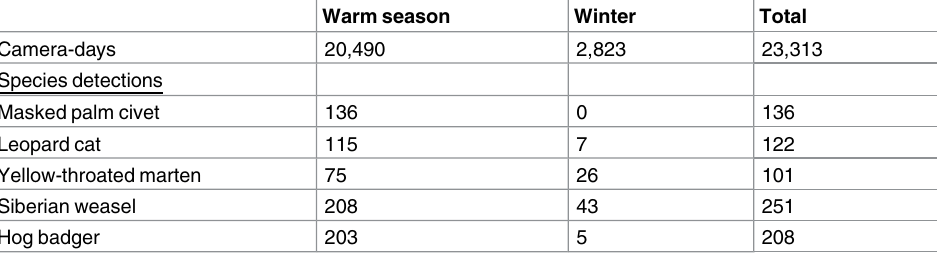
Table 2. Sampling efforts and numbers of independent detections of carnivore species during the camera-trap survey in Minshan Mountains, Sichuan, China from 2004 to